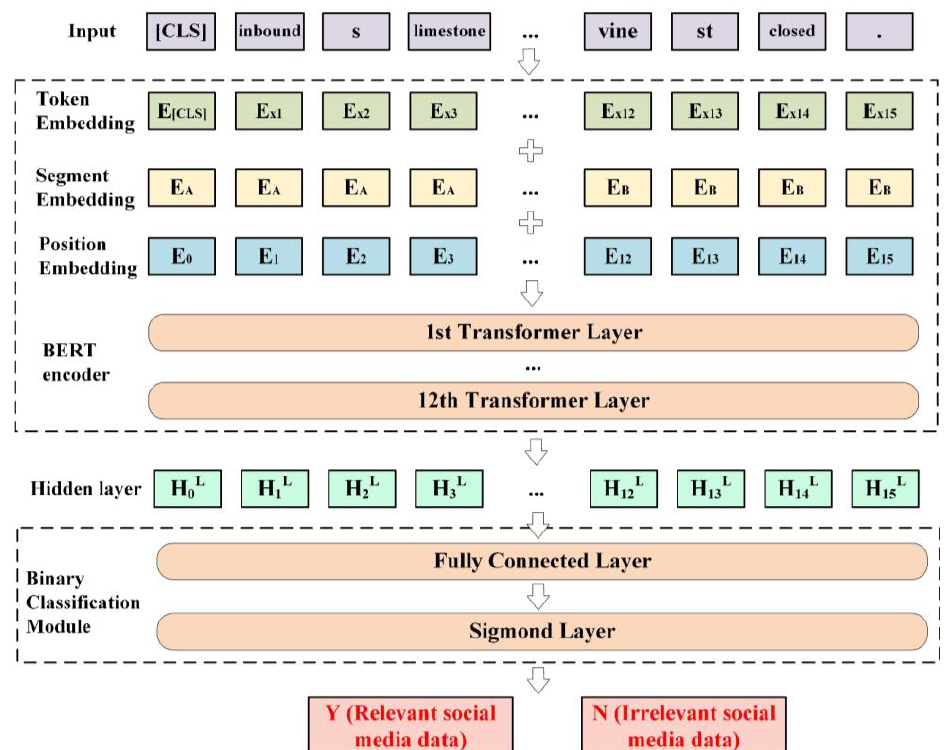
Figure 3. Binary classification model for cleansing social media data.